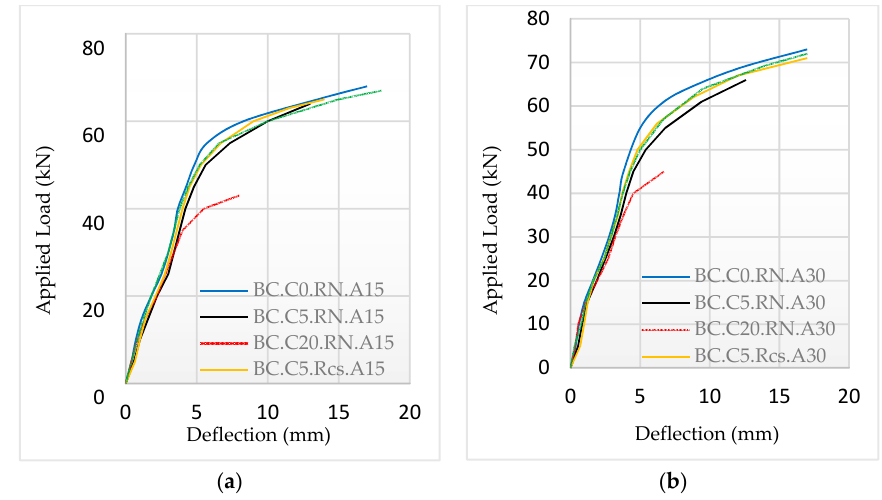
Figure 5. Comparison of load deflection response for each group. ( a ) Group A; ( b ) Group B.